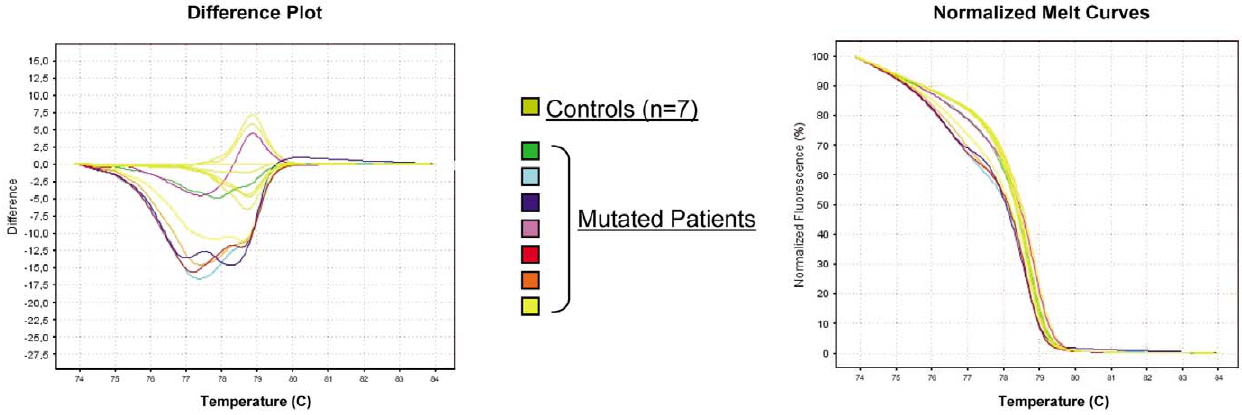
Figure 1. HRM analysis. HRM profiles of 7 patients known to harbor JAK2 exon 12 mutations compared to 7 controls. Analysis of total blood DNA on the ABI7500 fast instrument.